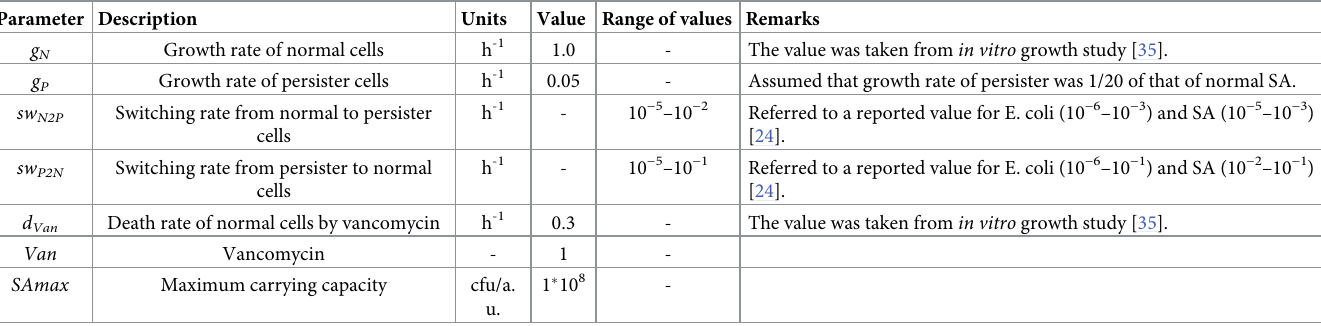
Table 1. Definition and values of the parameters for in vitro SA growth